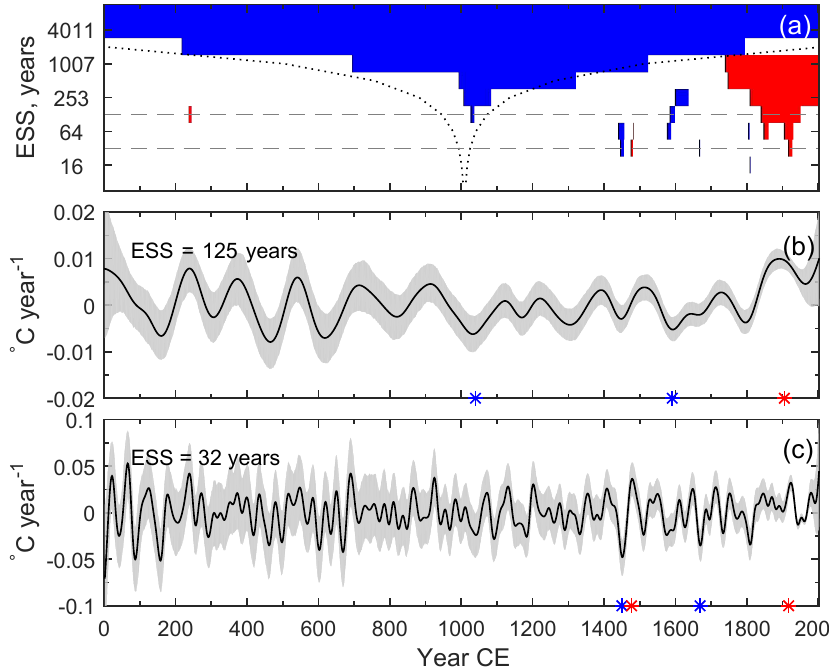
Figure 5. (a) Modified SiZer map of the spatial mean reconstructed SAT with colours red and blue marking the locations in scale (variability timescale) and space (time in this particular case) where the fraction of ensemble members exhibiting statistically significant warming and cooling exceeds 90%; the parallel distance between the dotted lines indicates the effective size of the smoothing kernel used for a particular scale and hence gives an idea of the corresponding timescale involved at that level of smoothing. Solid lines in (b) and (c) show derivatives of local linear smooth lines together with the respective double standard deviation ranges (highlighted grey) for the two selected kernel bandwidths log 10 ( h ) = { 0 . 9 , 1 . 5 } with effective sample sizes of about 125 and 32 years, also marked as dashes in panel (a) . Blue or red asterisks in (b, c) mark the timings of the maxima in the rates of cooling or warming discussed in the